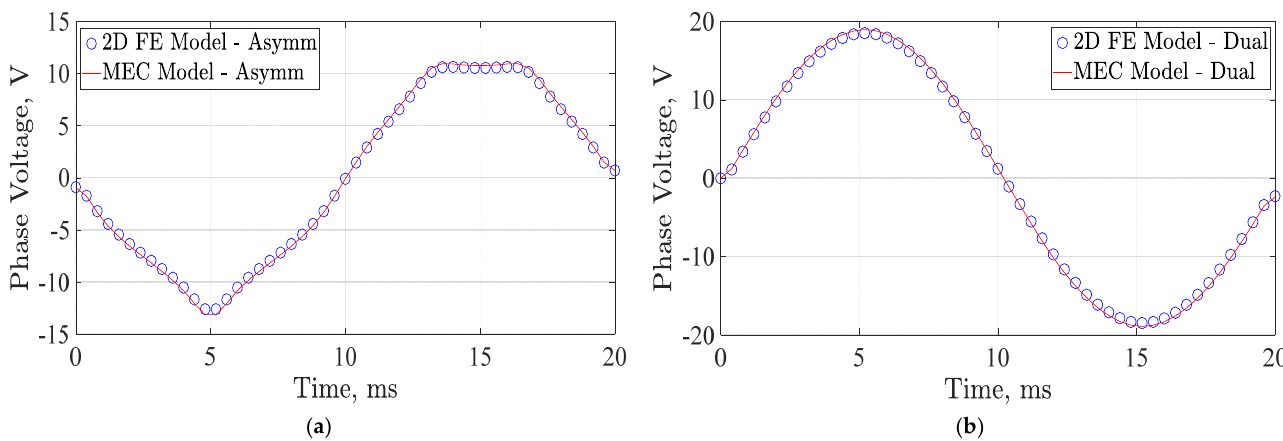
Figure 16. Phase voltage profiles under charging mode. ( a ) Asymmetrical winding layout and ( b ) dual three ‐ phase wind ‐